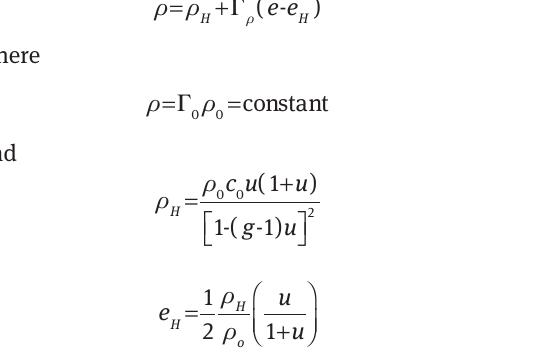
and base plates are modeled using nearly 60,000 par- ticles. The initial velocity is given as the initial condi- tion. For the flyer plate, the initial velocity 1000 m/s is applied in this work, and it is set to zero for the base plate. In order to ensure that the stress wave can reflect back in free surface rather than in other boundaries, the free boundary is designed to be in accord with the physi- cal conditions. And the initial impact angle between flyer and base plate is set to 20 ° .